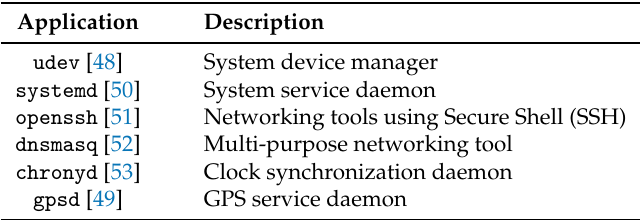
Table 4. A list of system management